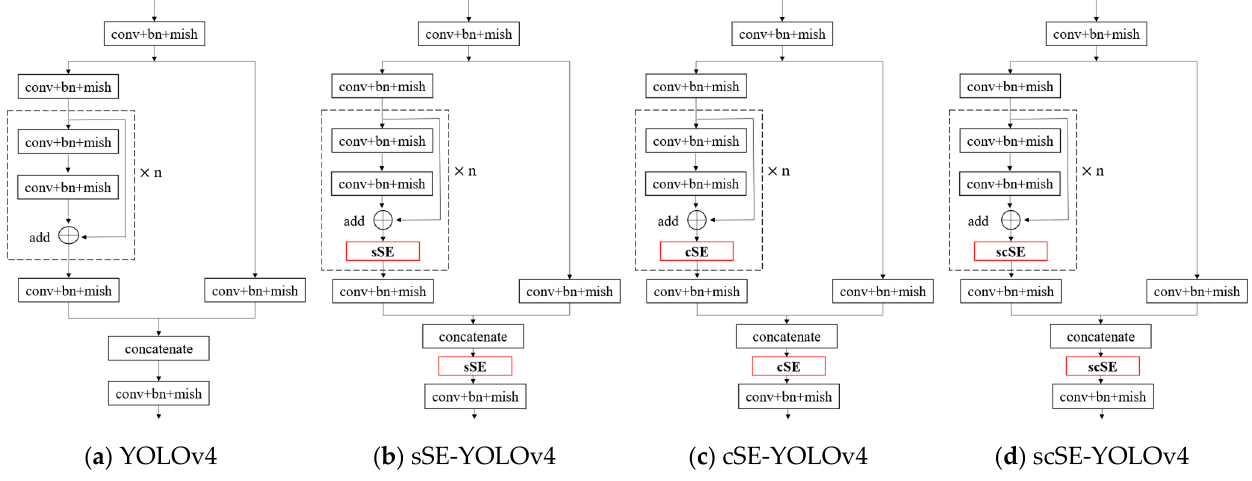
Figure 6. ( a ) represents the structure of the ResBlock body in the original YOLOv4 backbone network; ( b – d ) represent the sSE module, cSE module, and scSE module embedded into the YOLOv4 backbone network,